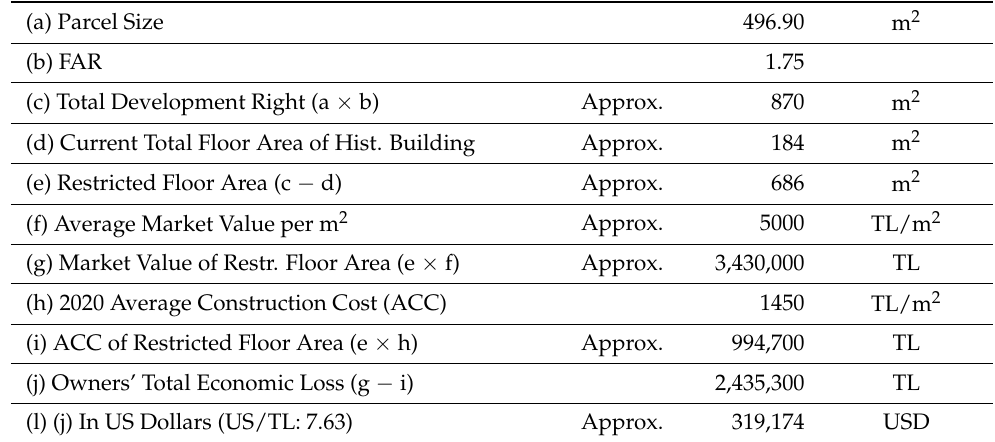
Table 2. Overview of the calculations of Example 2.